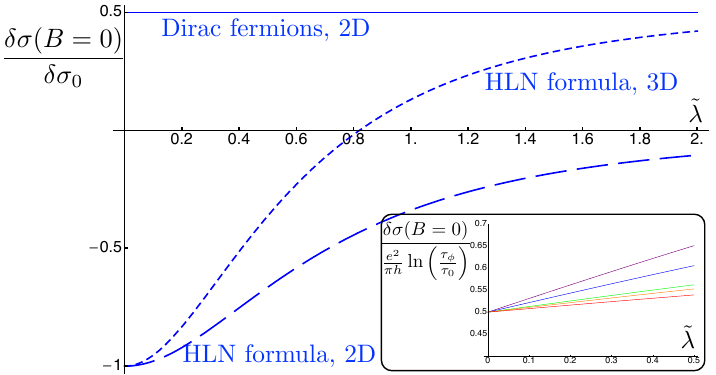
Figure 3. Plot of the zero-field quantum-interference conductivity correction in terms of the spin-orbit scattering strength λ for massless Dirac fermions (solid line), HLN formula for 2DEG (dashed line) and 3DEG (dotted line). δσ 0 = ( e 2 / π h ) ln ( τ φ / τ ) . In order to emphasize that the WAL conductivity of massless Dirac fermions is also dependent upon the spin-orbit impurity strength, the inset shows WAL in units independent of λ , i.e., ( e 2 / π h ) ln ( τ φ / τ 0 ) , where τ 0 is the scattering time in the absence of spin-orbit impurities and the ratio τ φ / τ 0 varies from 5 (purple), 10 (blue), 50 (green), 100 (orange) to 500 (red). Adapted from Figure 3 in